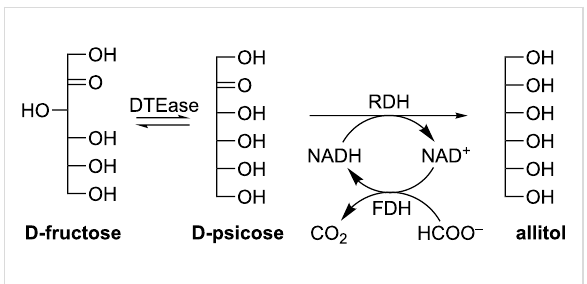
Scheme 17: Synthesis of allitol from D-fructose using a multi-enzyme